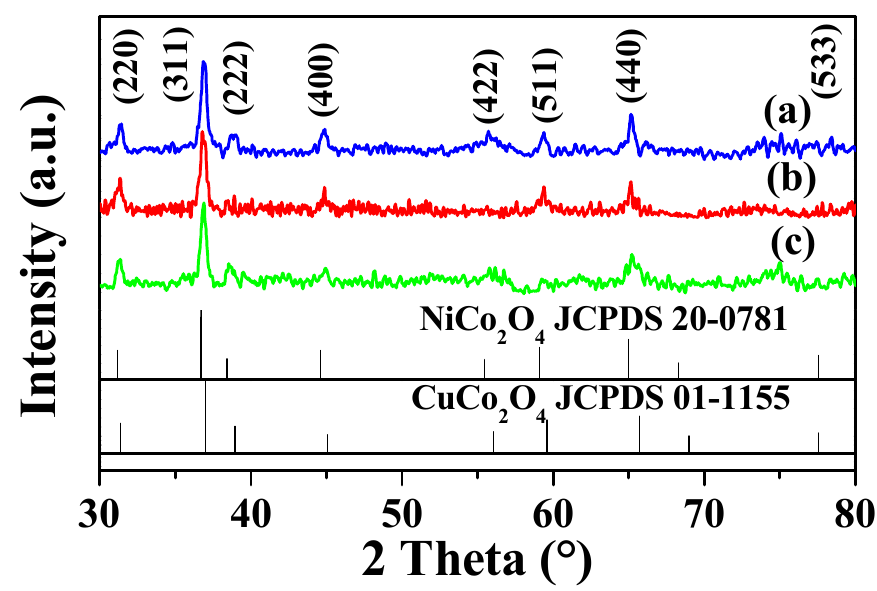
Figure 1. XRD patterns of the Ni 0.5 Cu 0.5 Co 2 O 4 nanoparticles ( a ), urchin-like microspheres ( b ), and nanoplatelets ( c ).